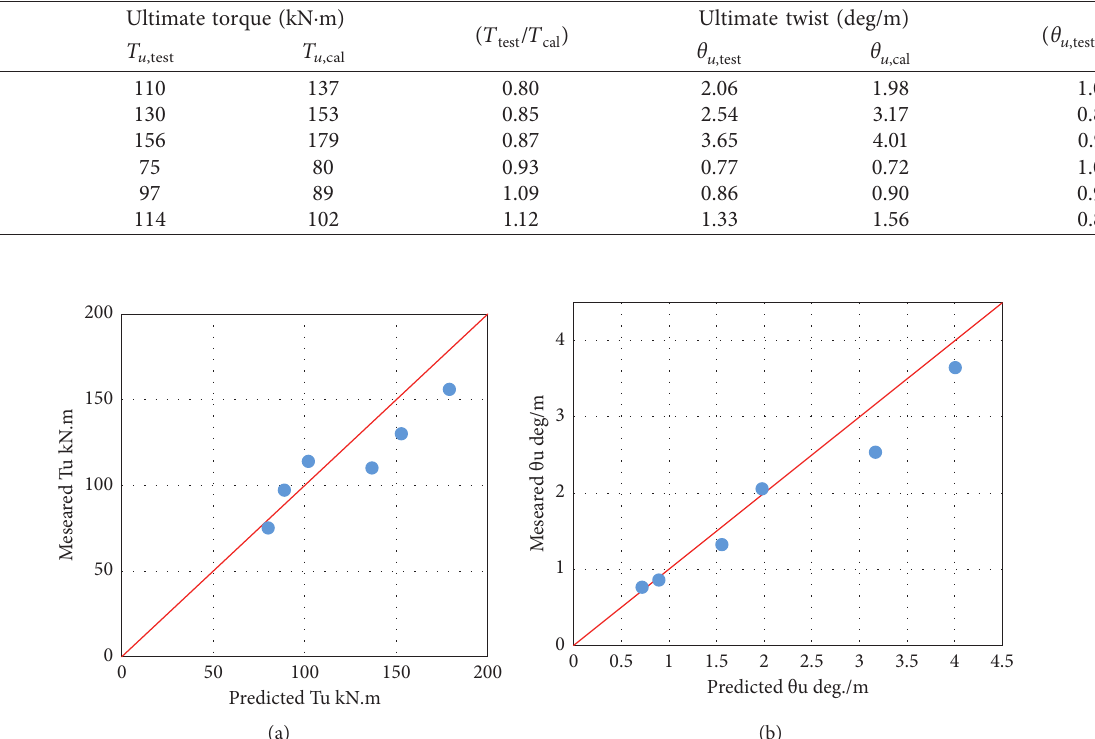
u versus predicted T u . (b) Measured θ u versus